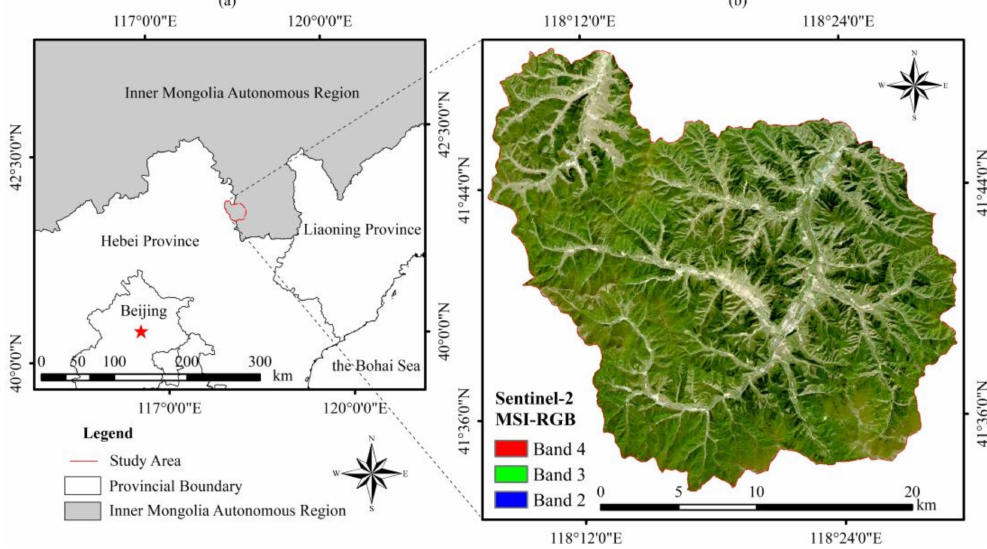
Figure 1. ( a ) Location and boundary of the Wangyedian forest farm and ( b ) Sentinel-2 image covering the study